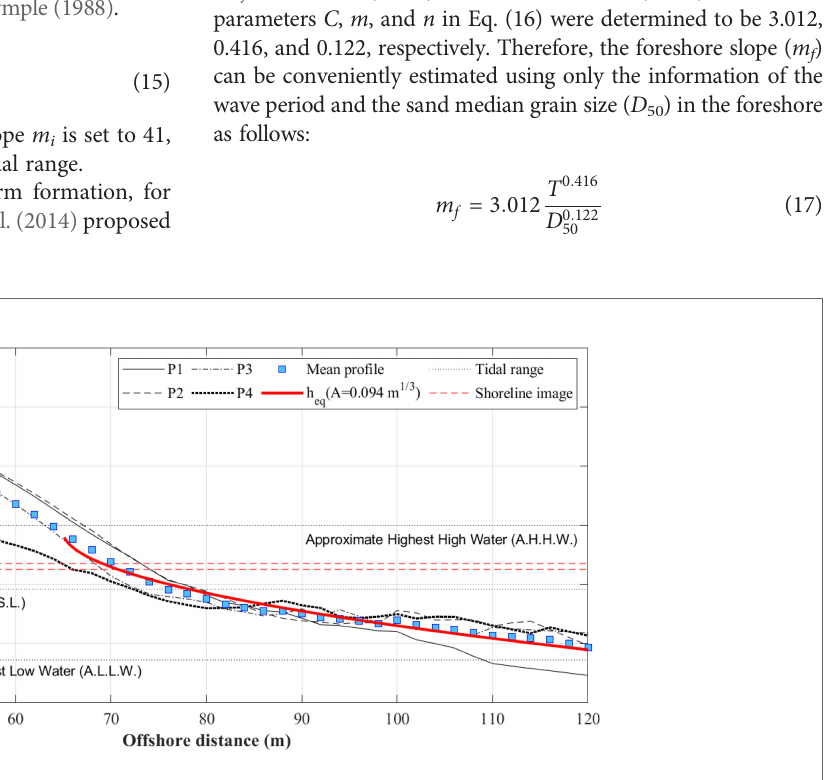
FIGURE 7 | Equilibrium beach pro fi le (red line) for estimating the beach scale